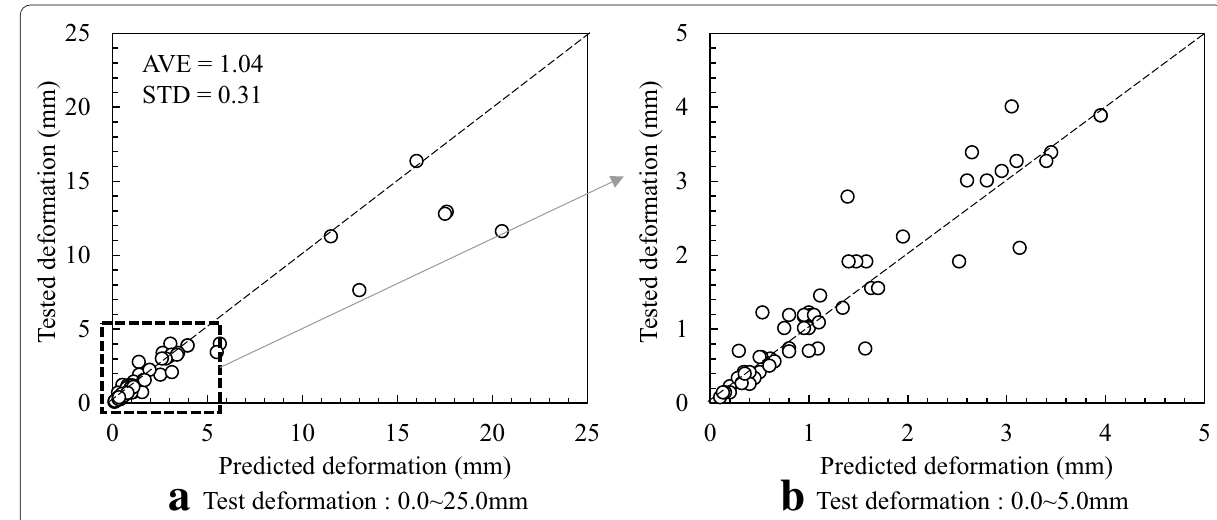
Fig. 17 Comparison between test data and prediction results of the critical deformation.